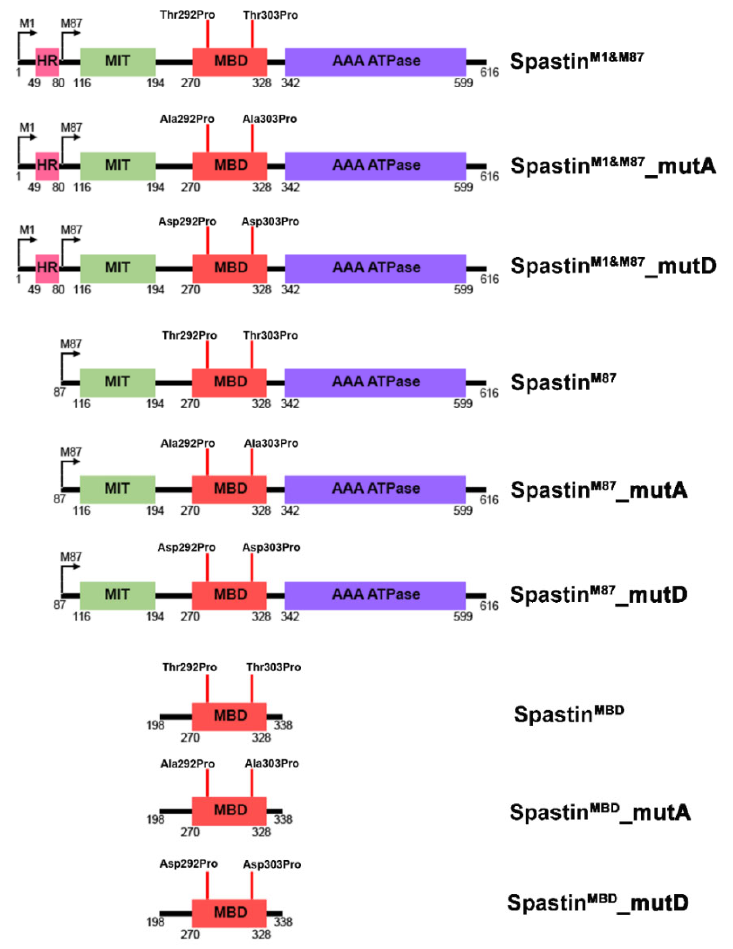
Figure 1. The representative illustrations of the cloned Spastin constructs used in the study. The full-length wild-type or mutant Spastin constructs expressing both M1 and M87-Spastin isoforms are named Spastin M1&M87 (Thr292Pro&Thr303Pro), Spastin M1&M87 _mutA (Ala292Pro&Ala303Pro), or Spastin M1&M87 _mutD (Asp292Pro & Asp303Pro), and wild-type or mutant Spastin constructs expressing only the M87 isoform of Spastin are named Spastin M87 , Spastin M87 _mutA, and Spastin M87 _mutD, respectively. In addition, the wild-type or mutant constructs expressing only the microtubule-binding domain (MBD) of Spastin consisting of amino acids from 198 to 338 are named Spastin MBD , Spastin MBD _mutA, and Spastin MBD _mutD.